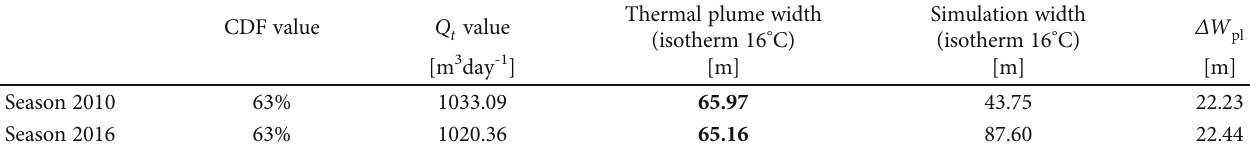
Table 5: Detailed results of plume width evaluated by fi xing CDF equal to 63%.